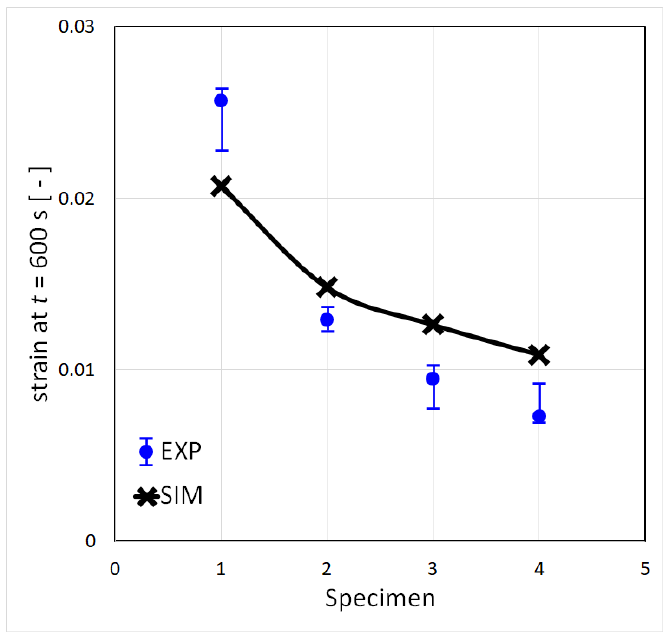
Figure 3. Creep strain at t = 600 s under the stress of 932